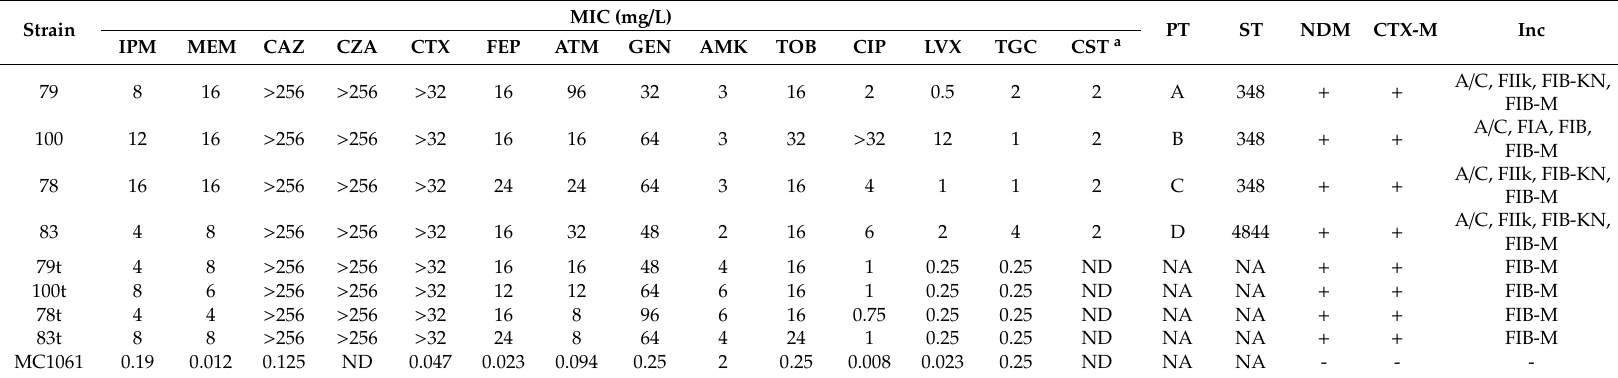
Table 1. Antimicrobial susceptibility and molecular characterization of selected K. pneumoniae isolates and their corresponding transconjugant E. coli strains ( E. coli MC1061AziR strain was used as